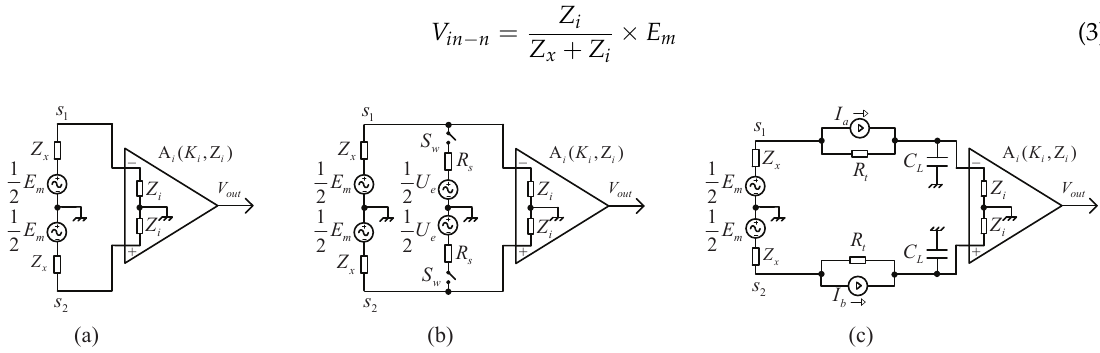
Figure 3. Principal diagram of the electrode measurement loop of the electromagnetic flow meter (EMFM). ( a ) No electrical excitation; ( b ) parallel electrical excitation; mode ( c ) serial electrical excitation